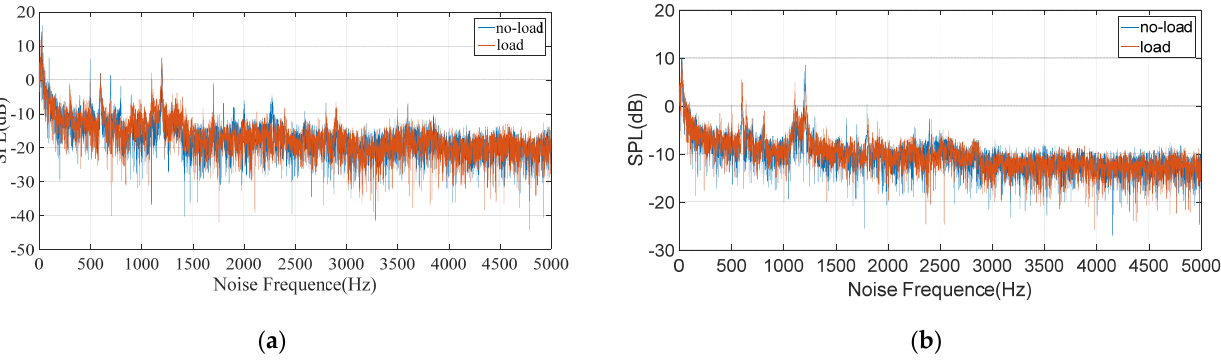
Figure 15. Comparison of SPL spectra of idle and loaded motors: ( a ) 120 rpm SPL under half-step